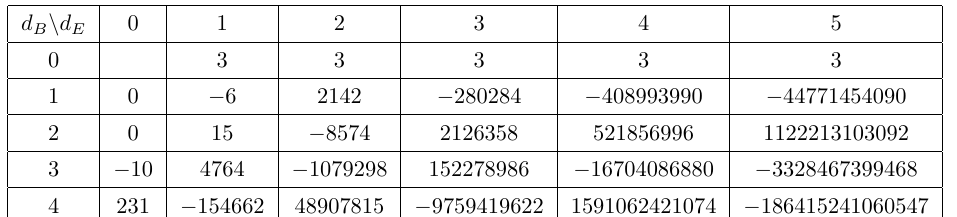
for the genus ( g ) = (1 , 0) . L , g R ( d B ,d E )